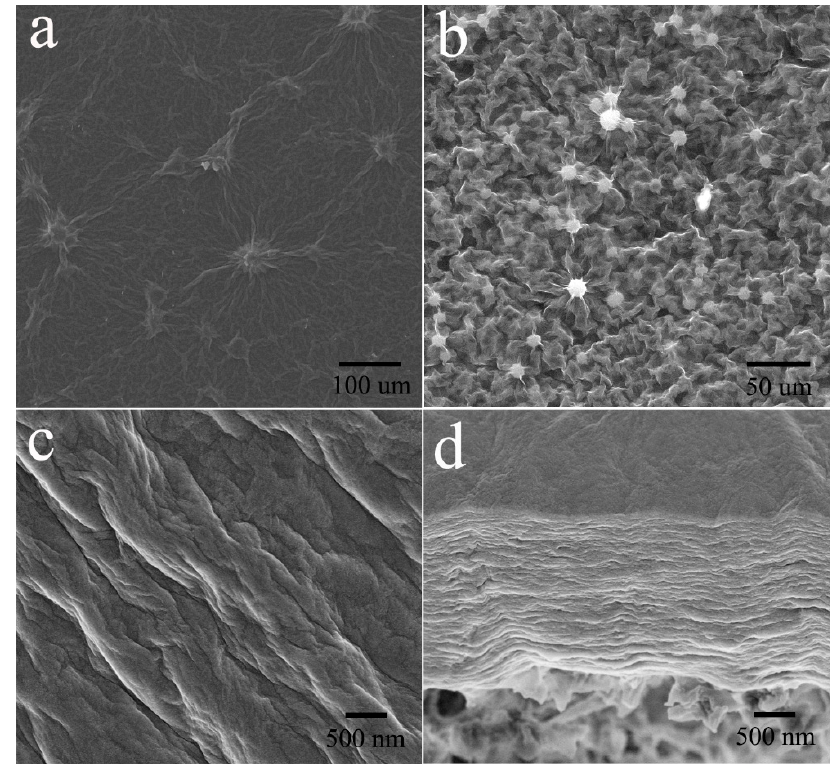
Figure 2. SEM ( a ) images of the surface of GO membrane. ( b ) SEM images of the surface of GO/EG membrane. FESEM images of ( c ) the surface and ( d ) the cross section of GO/EG composite membrane.